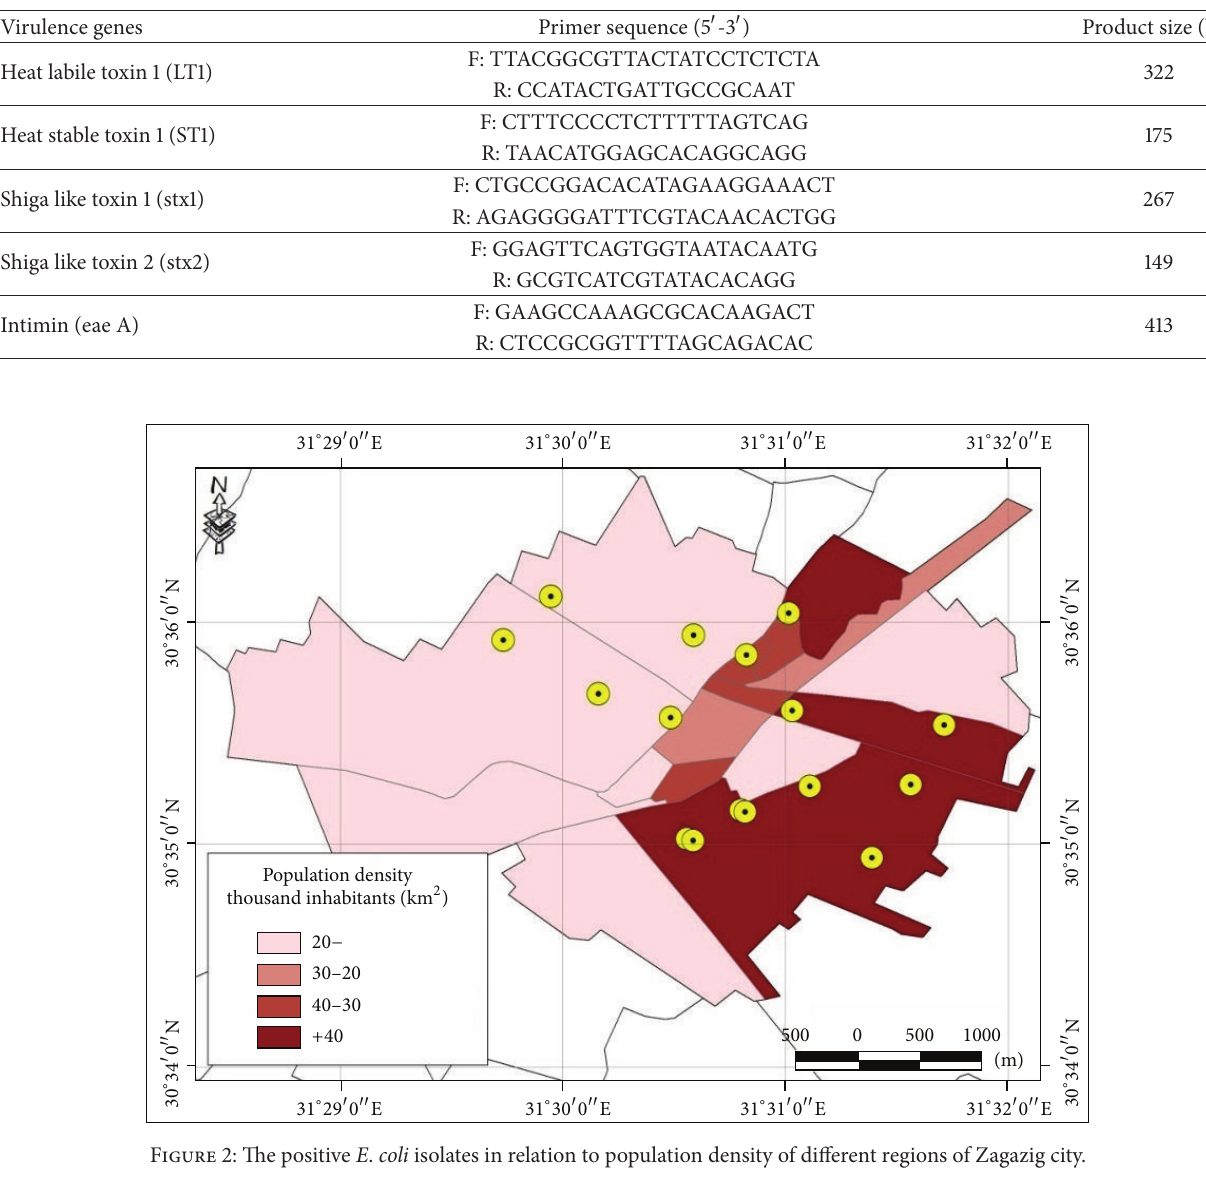
MacConkey broth and EMB for isolation of coliform and E . coli